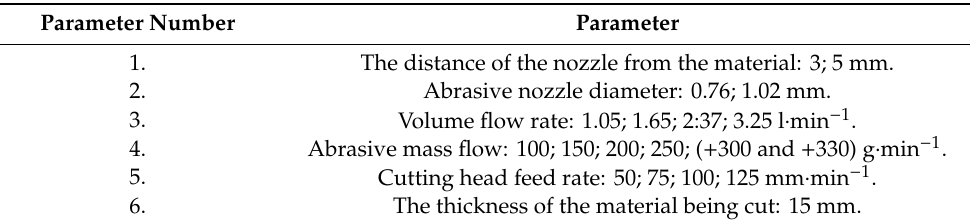
Table 4. Data and main cutting parameters of the test sample.